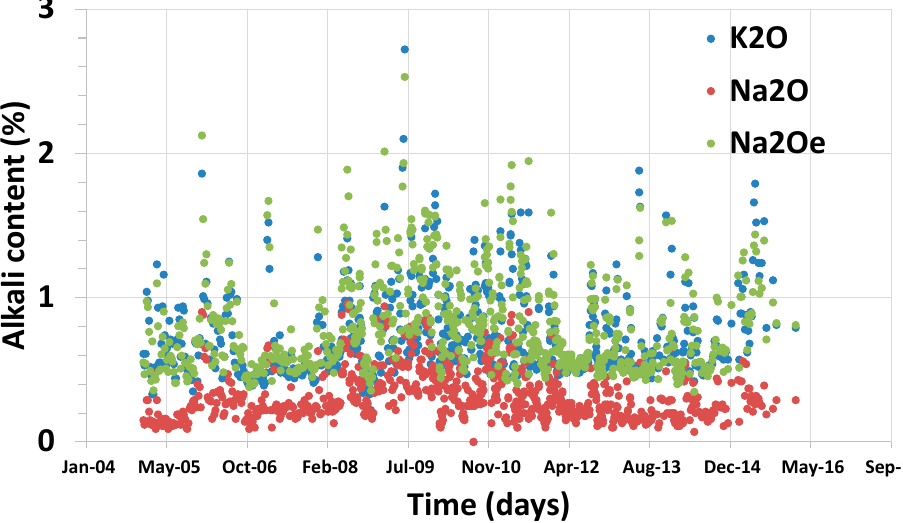
Figure 2. Maximum, minimum, and average values of Na 2 O, K 2 O, and Na 2 O e in coal fly ash. Coal fly ashes are utilized worldwide to manufacture blended cements and